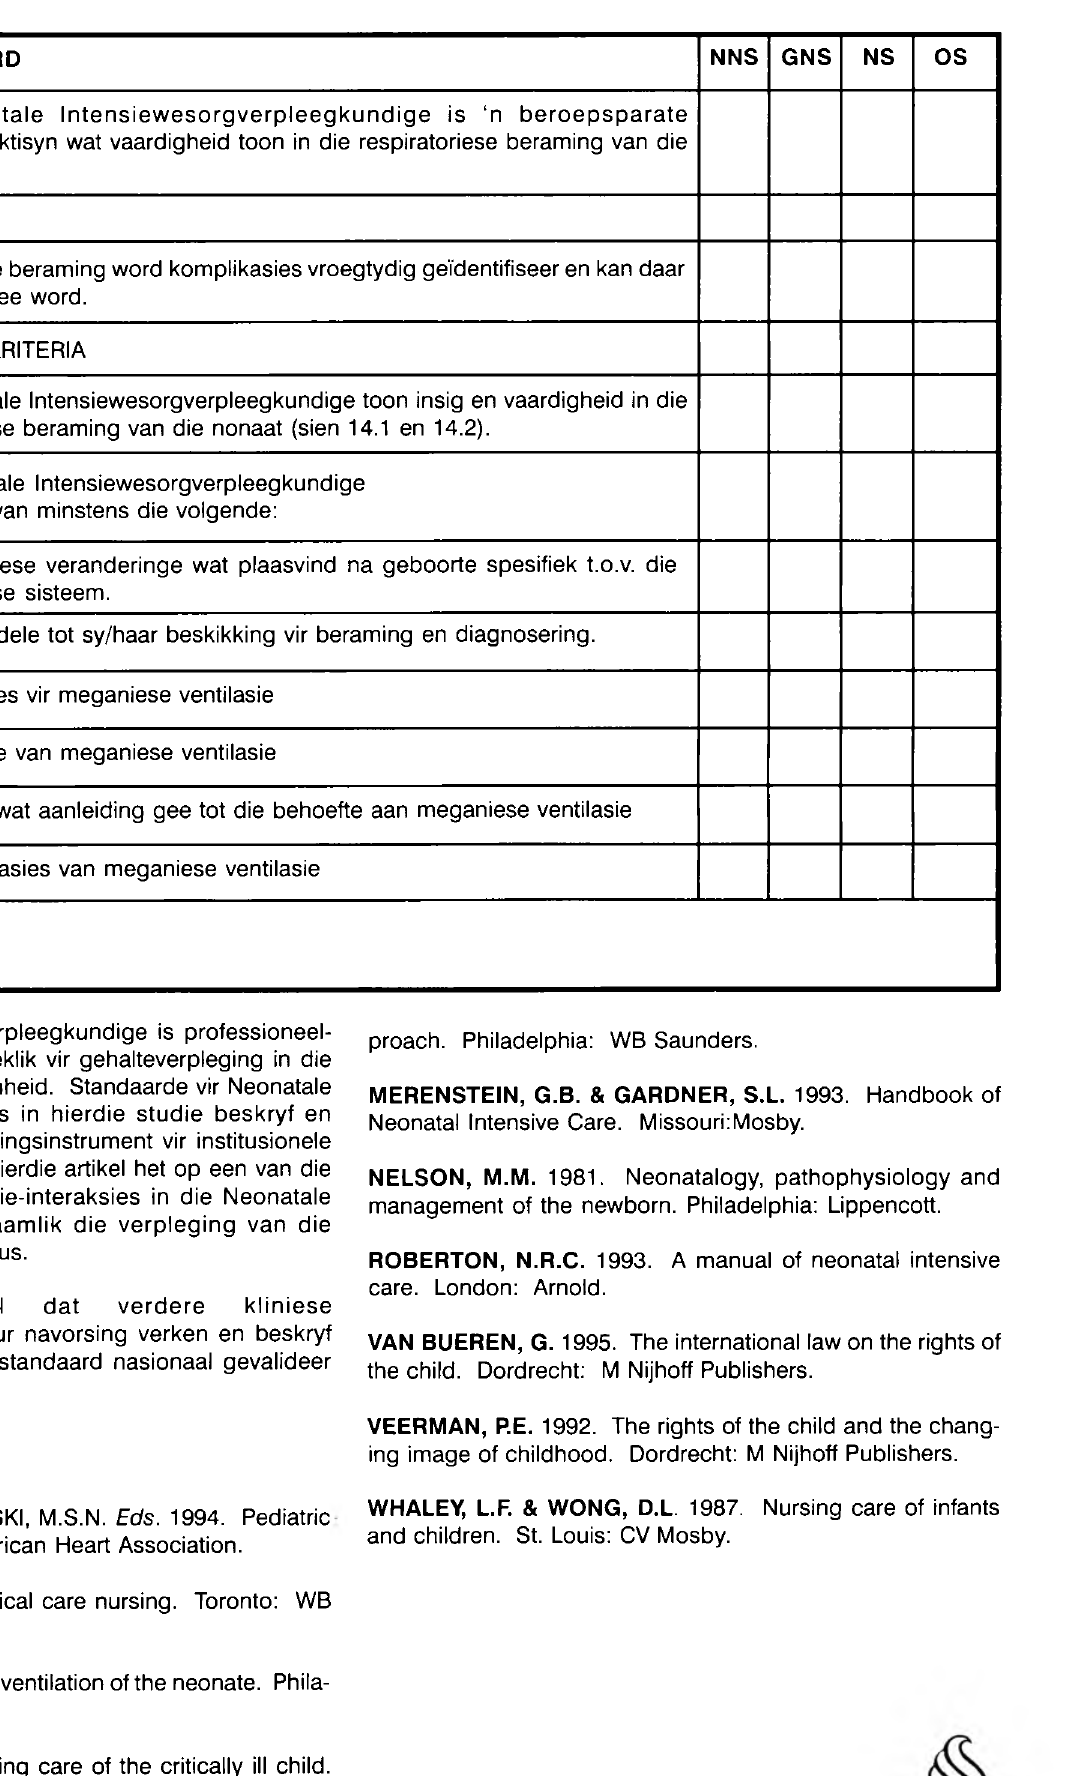
Figuur 1: Voorbeeld van Kliniese Standaard STANDAARD NNS GNS NS OS